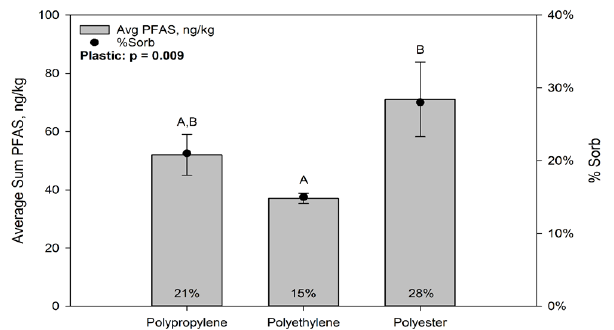
Figure 6. Average Summed 3 PFAS concentration (ng/kg) and Percent Adsorption (number above each bar) of PFAS on Plastic for Laboratory Study. Different letters among bars indicate statistically significant differences among sites for either the 1 month or 3 month incubation period.